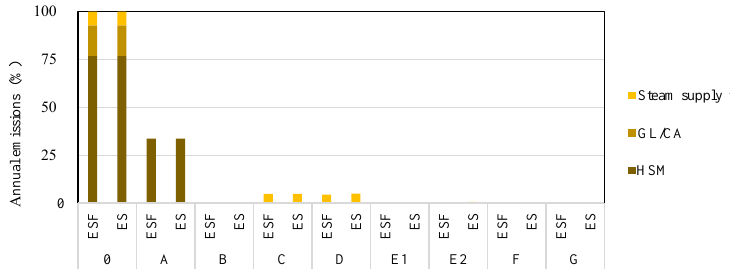
Figure 11. Annual CO 2 emission reduction for the finishing line in